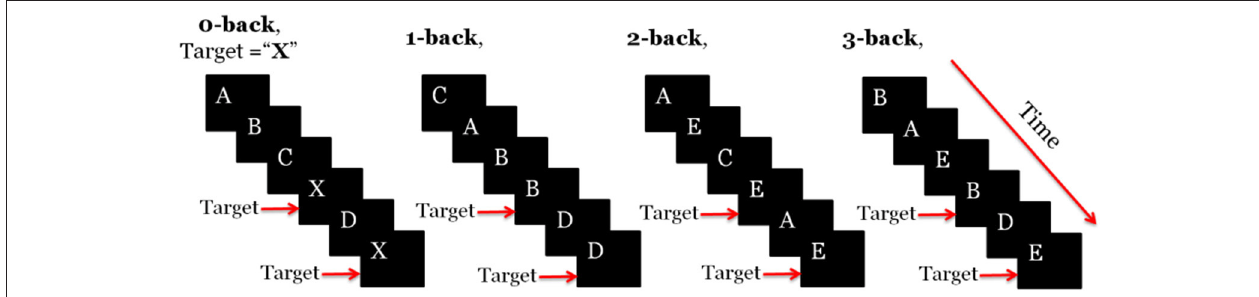
FIGURE 1 | Schematic illustration of the letter n -back task for n ǫ {0, 1, 2, 3}.